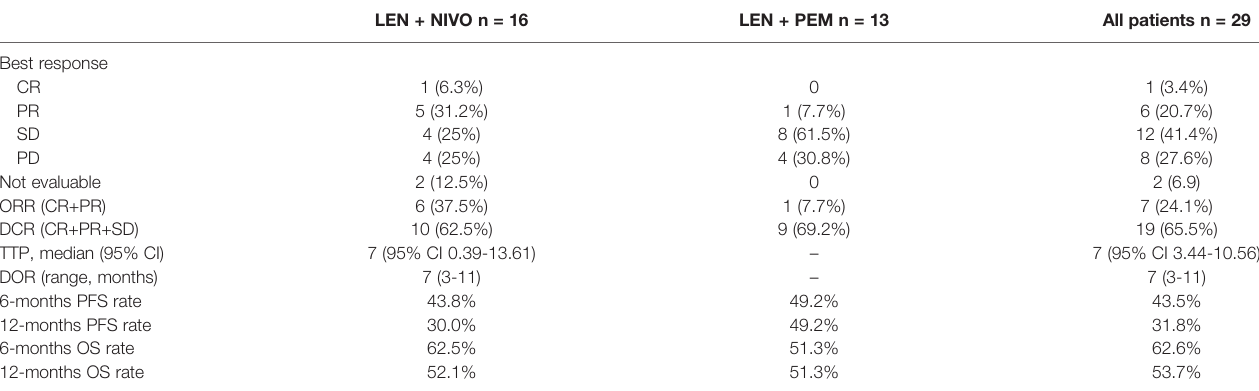
TABLE 2 | Radiological response according to RECIST1.1 and survival.